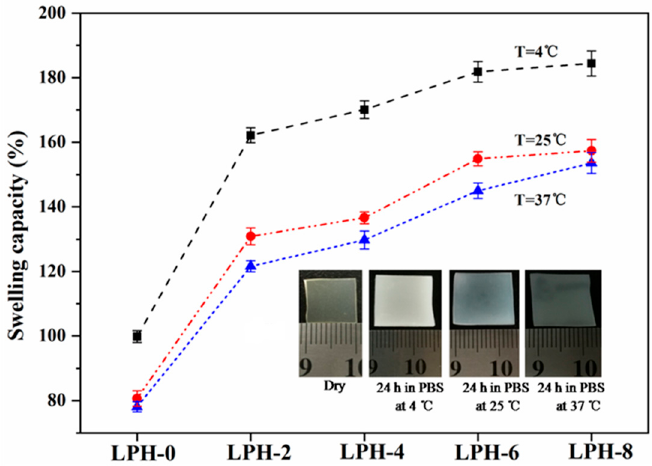
Figure 8. Water absorption of the LPH films at different temperatures.